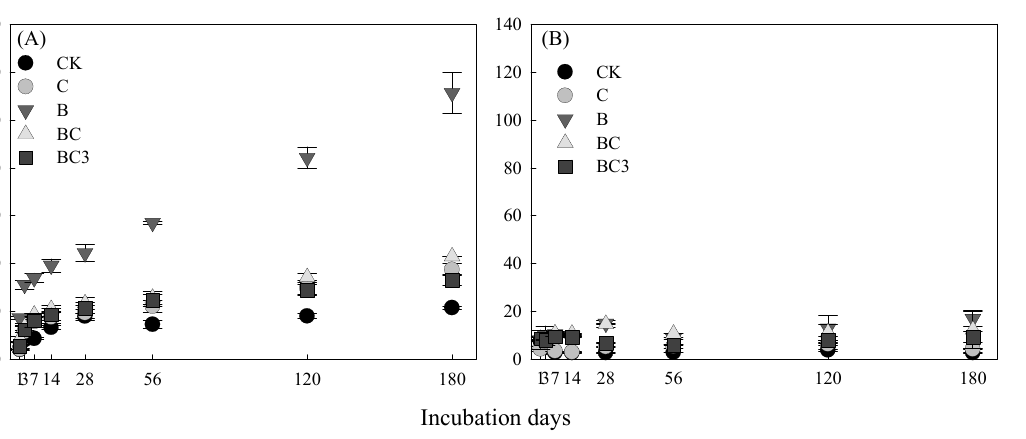
(B) CK C B BC BC3 Figure 3. Dynamic changes to the available P content during the experiment period ( A ) sandy soil ( B ) clay soil.